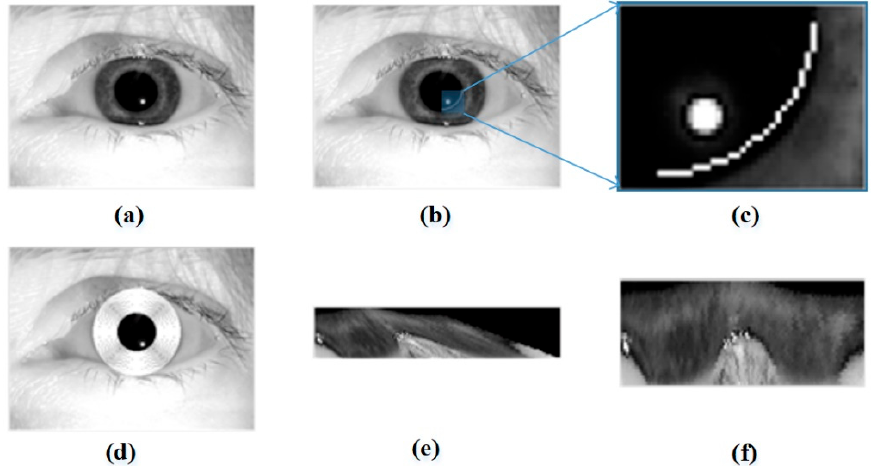
Figure 6. Illustration of the iris unwrapping process: ( a ) Input image; ( b ) pixel locations of a quadrant of a circle are calculated; ( c ) close-up view of one quadrant; ( d ) concentric circles encompassing the iris; ( e ) unwrapped iris without scaling; and ( f ) unwrapped iris with